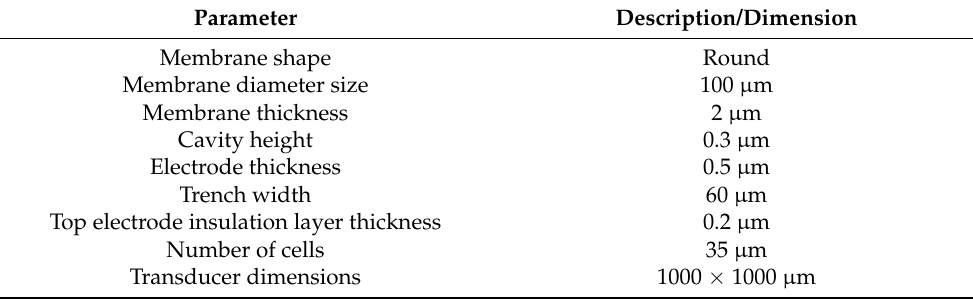
Table 1. CMUT array parameters and